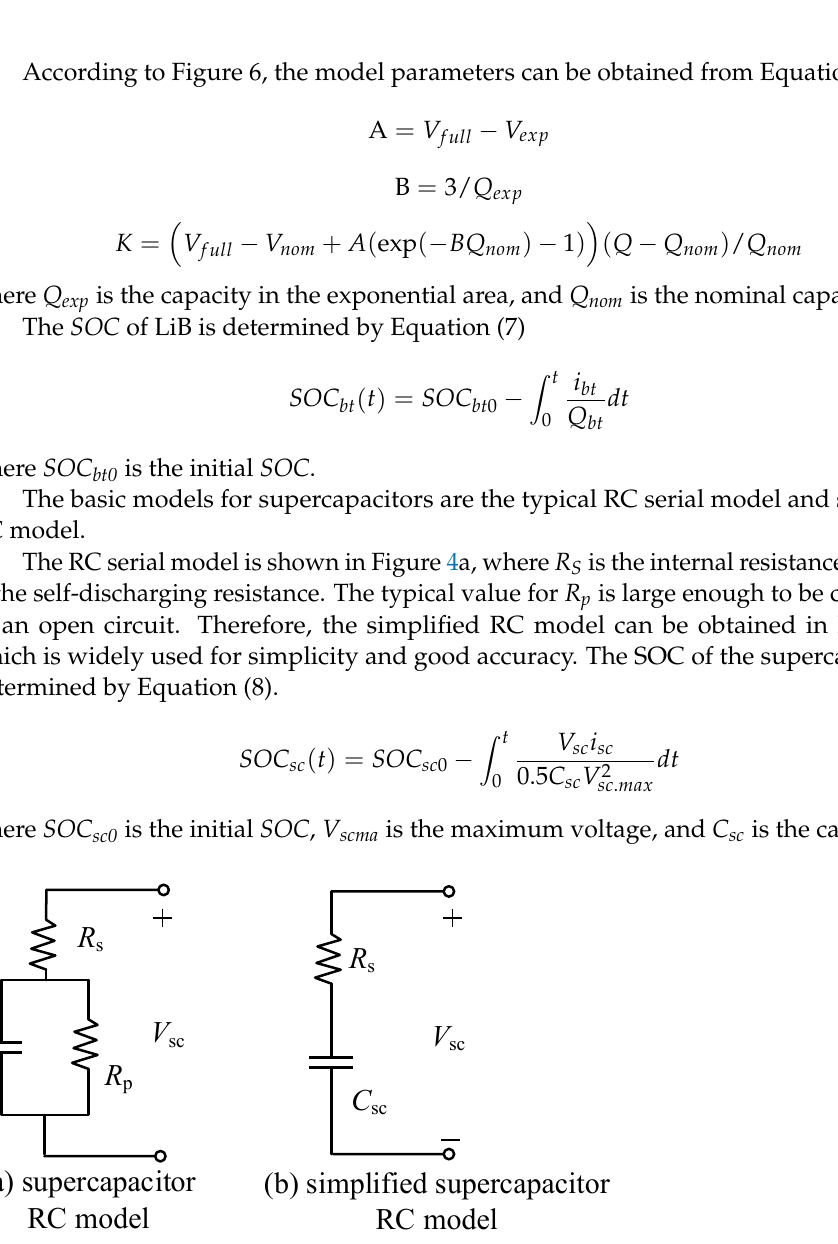
Figure 5. The current control loop for DC/DC converter.